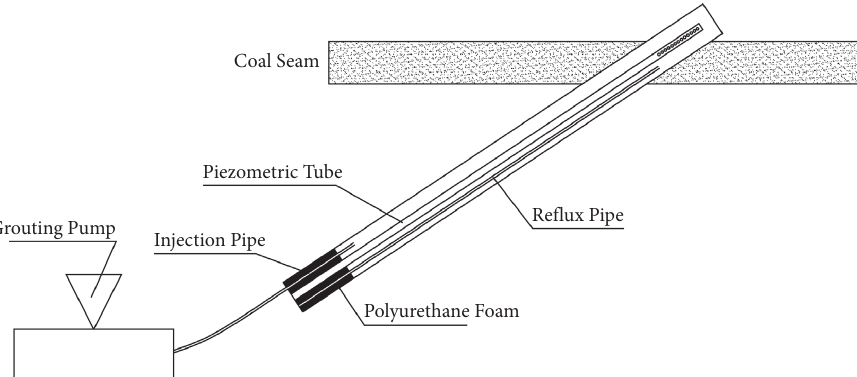
Figure 17: Schematic diagram of borehole sealing for measuring residual gas pressure.